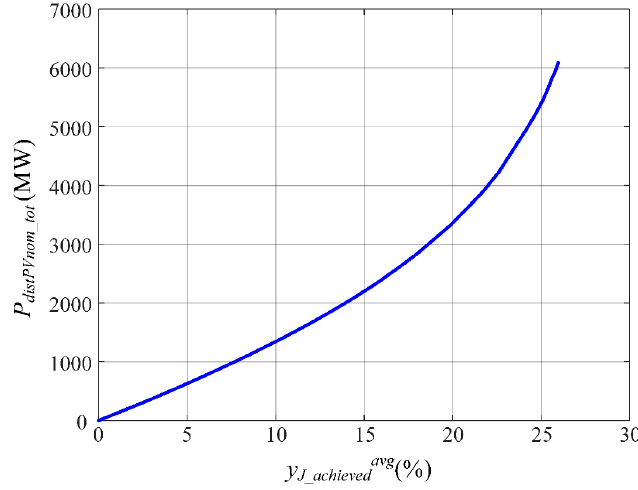
Figure 5. The required installed capacity of distributed PV systems for achieving a certain weighted average value of Joule’s losses reductions in distribution networks in Serbia. average value of Joule’s losses reductions in distribution networks in Serbia.